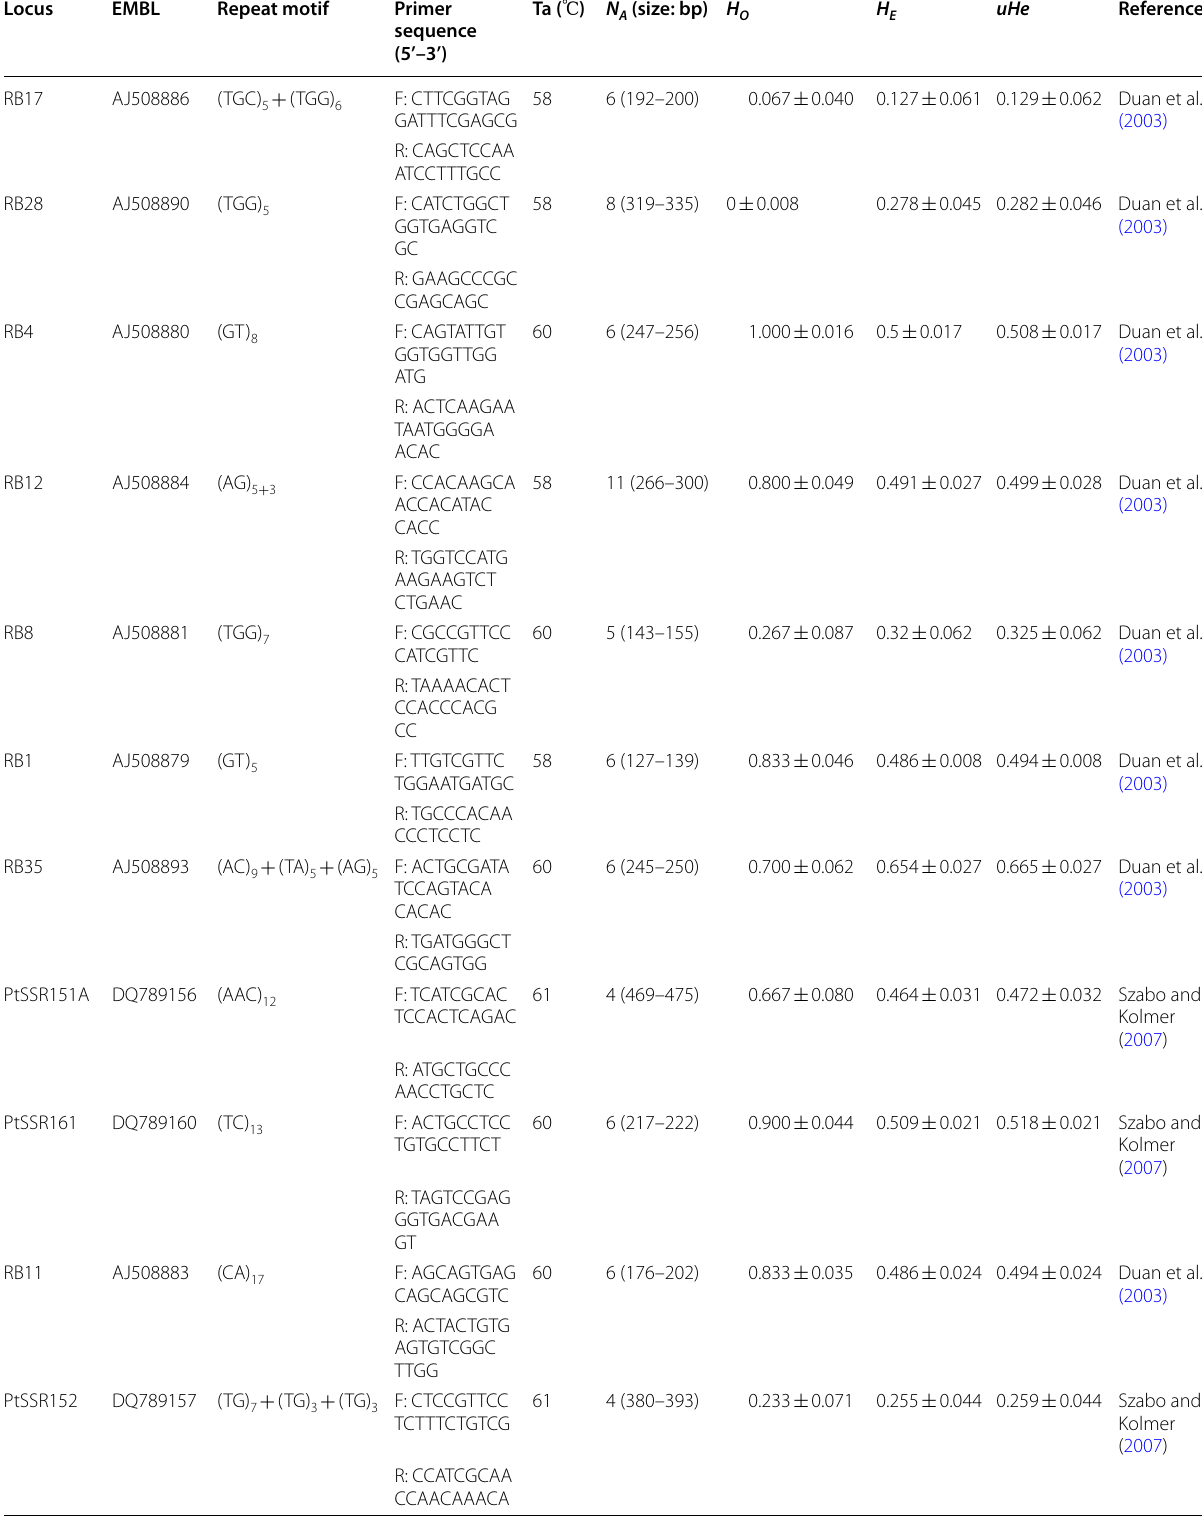
Table 1 Sequence information, number of alleles ( N expected heterozygosity ( uHe ) of 16 codominant simple sequence repeat (SSR) markers employed in this